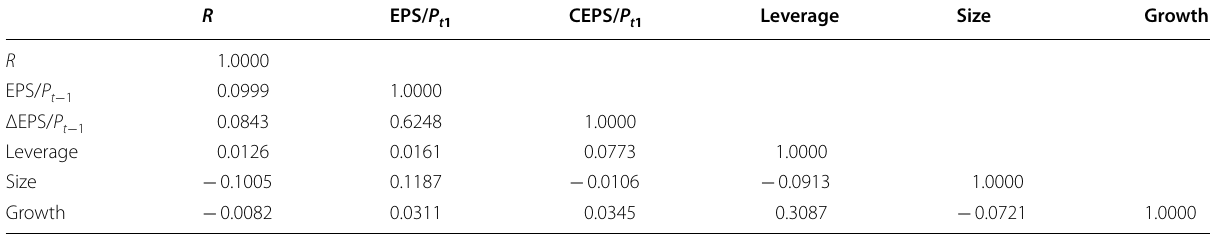
Table 6 Correlations analysis using control